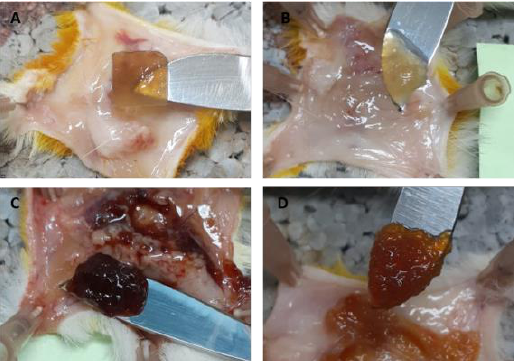
Figure 12. Degradation of CaP ( A , B ) and FeP ( C , D ) hydrogels during subcutaneous implantation in laboratory rats. ( A , C )—after 1 day of implantation, ( B , D )—after 7 days of